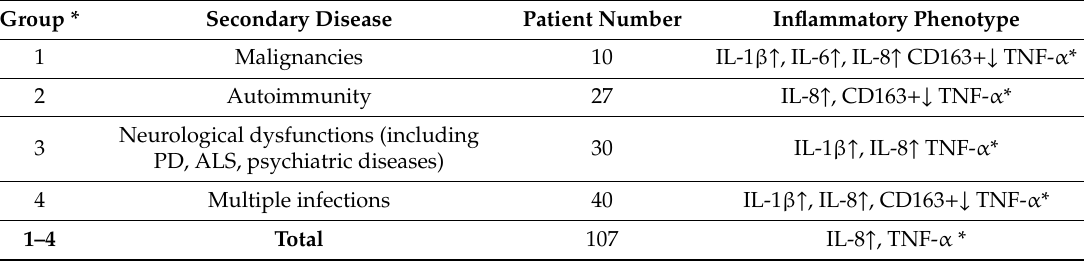
Table 1. Distribution of the patients into four subpopulations with a pattern of secondary disease phenotypes. First group consists of patients with malignancies, group 2 of patients with an additional autoimmune diseases (including e.g., multiple sclerosis, arthritis, diabetes mellitus type I, Hashimoto thyroiditis, and Morbus Basedow), group 3 of patients with additional neurological dysfunctions (including Parkinson’s disease (PD), amyotrophic lateral sclerosis (ALS), chronic fatigue syndrome (CFS), and depression), and group 4 of patients with unspecific clinical symptoms but multiple bacterial and / or viral coinfections. All groups (total) have increased IL-8, and TNF- α is not di ff erent from controls (see table below).